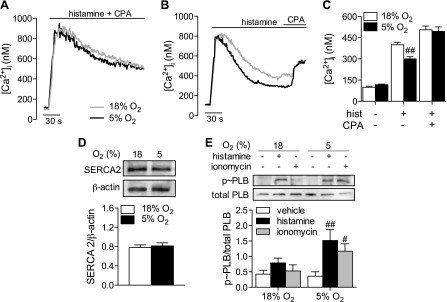
Inhibition of SERCA restores plateau [Ca2+] under 5% O2. HUVECs were cultured under standard (18%) or physiologic (5%) O2 levels and changes in [Ca2+]i determined using fura-2. A, B) Histamine (10 µM) stimulated Ca2+ mobilization with simultaneous (A) or sequential (B) addition of CPA (10 µM). C) Representative traces and mean ± sem plateau [Ca2+]i values. D) Expression of SERCA2 relative to β-actin. E) Histamine (10 µM, 30 s) and ionomycin (1 µM, 30 s) stimulated phosphorylation of PLB at S16/T17, expressed relative to total PLB levels. Representative immunoblots are shown. Densitometric analyses denote mean ± sem of measurements in 4 different donors. #P < 0.05, ##P < 0.01 vs. 18% O2.